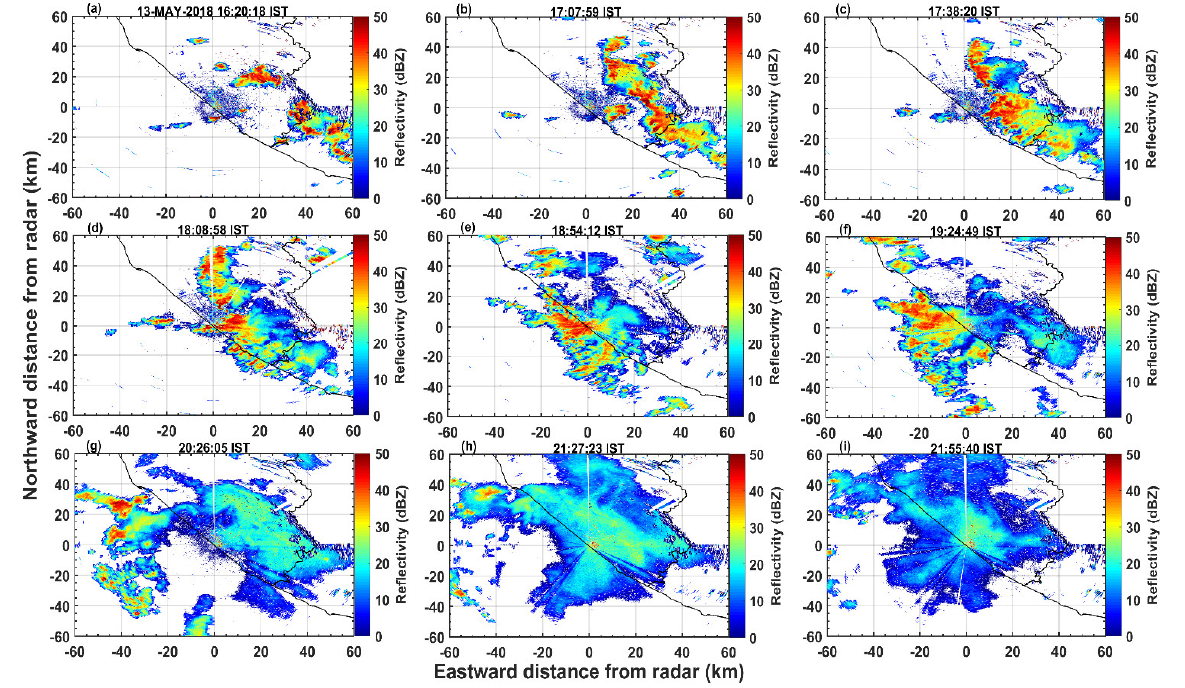
Figure 8. PPI diagrams of radar reflectivity at 2° elevation angle from 16:20:18 IST to 21:55:40 IST ( a – i ) during the event on 13 May 2018.